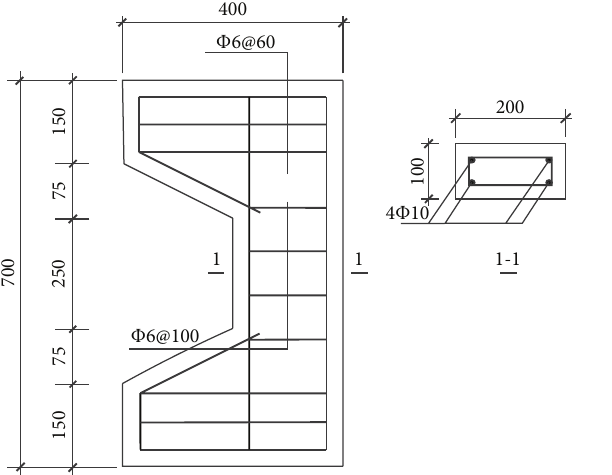
Figure 1: Reinforcement arrangement and dimensions of column specimens.